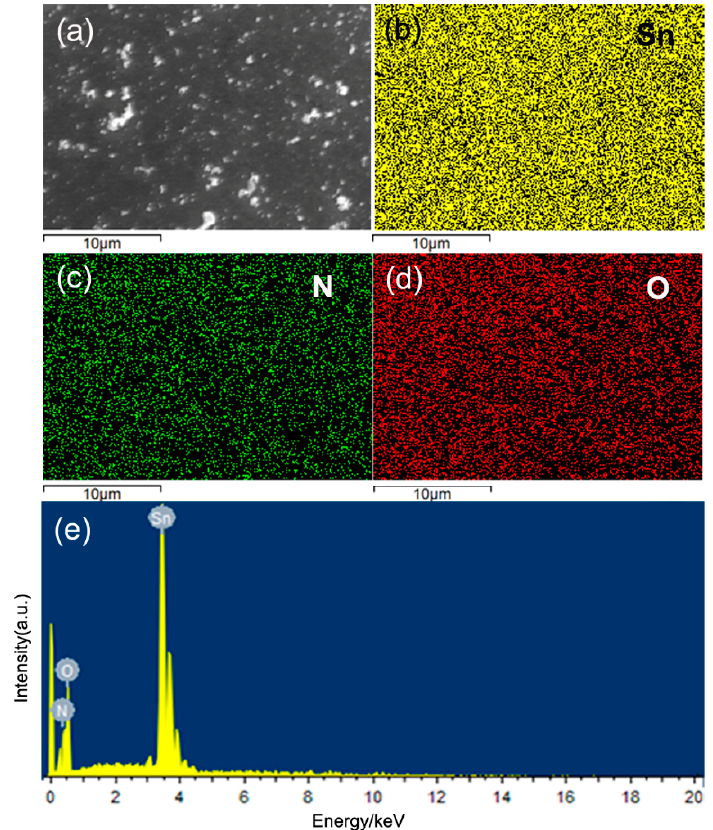
Figure 5. ( a ) Scanning electron microscopy (SEM) image and X-ray mapping of ( b ) Sn, ( c ) N, ( d ) O, and ( e ) energy dispersive spectrometry (EDS) spectrum of the N-incorporated SnO 2 sample.